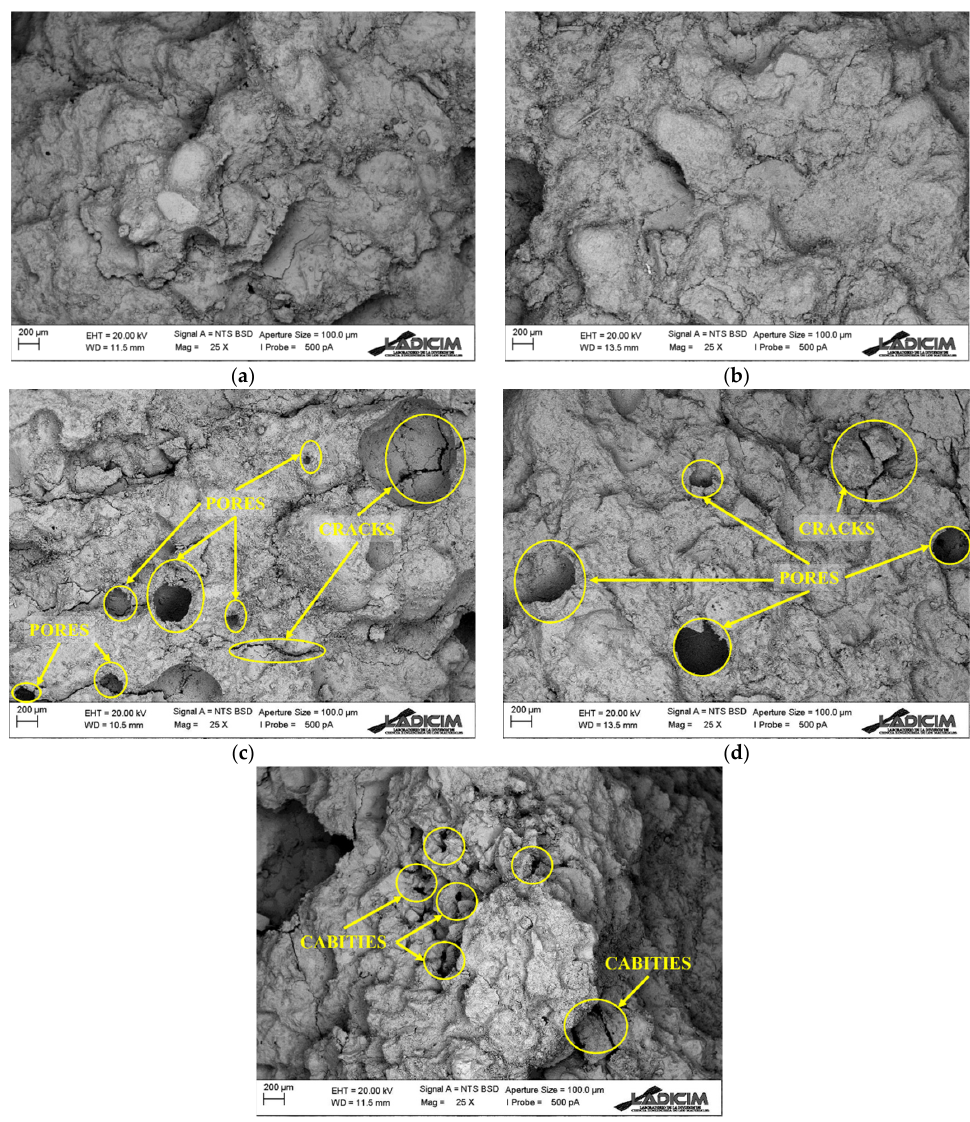
Figure 21. Microstructural analysis under 25× magnification: pores, cracks and cavities of UFS mortars with 0% ( a ), 25% ( b ), 50% ( c ), 75% ( d ) and 100% ( e ) substitution.